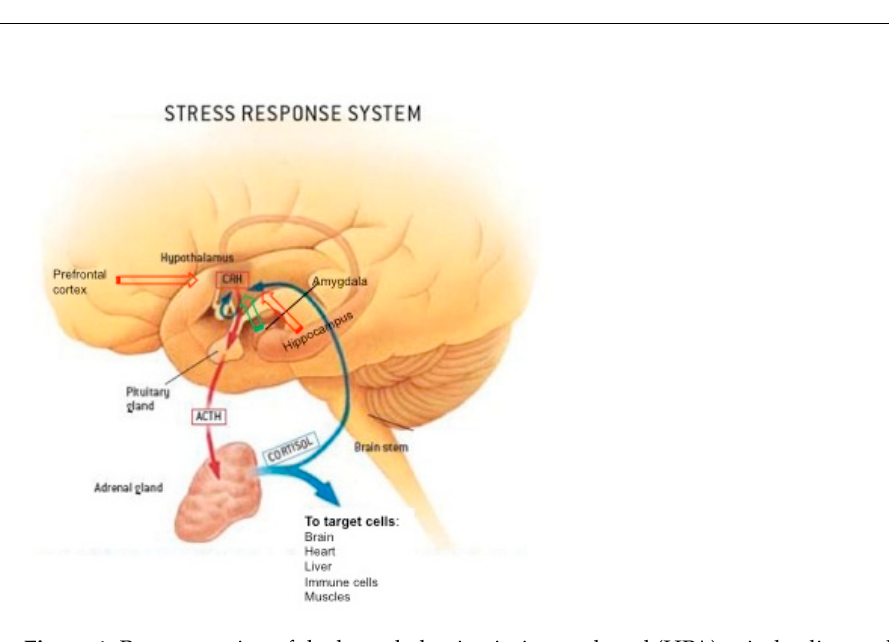
Figure 1. Representation of the hypothalamic-pituitary-adrenal (HPA) axis, leading to the secretion of glucocorticoid hormones (cortisol in humans, corticosterone in rodents). Prefrontal cortex and hippocampus regulating negatively the HPA axis have a red arrow whereas amygdala that regulates the HPA axis positively has a green arrow pointing to the hypothalamus. Glucocorticoids regulate their own synthesis by feedback controls (thin blue arrow).